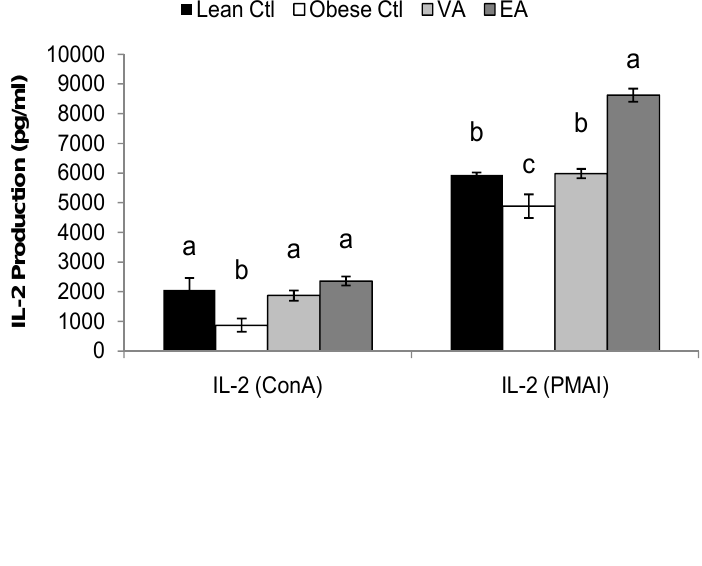
Data represent mean  SEM; n = 8/group. Means within the same row that do not share a common letter are significantly different (p < 0.05). Figure 1. Mitogen-stimulated IL-2 production. Bars represent mean ± SEM, n = 8/group. Bars not sharing a common letter are significantly different (P < 0.05). Ctl, control; VA, vaccenic acid; EA, elaidic